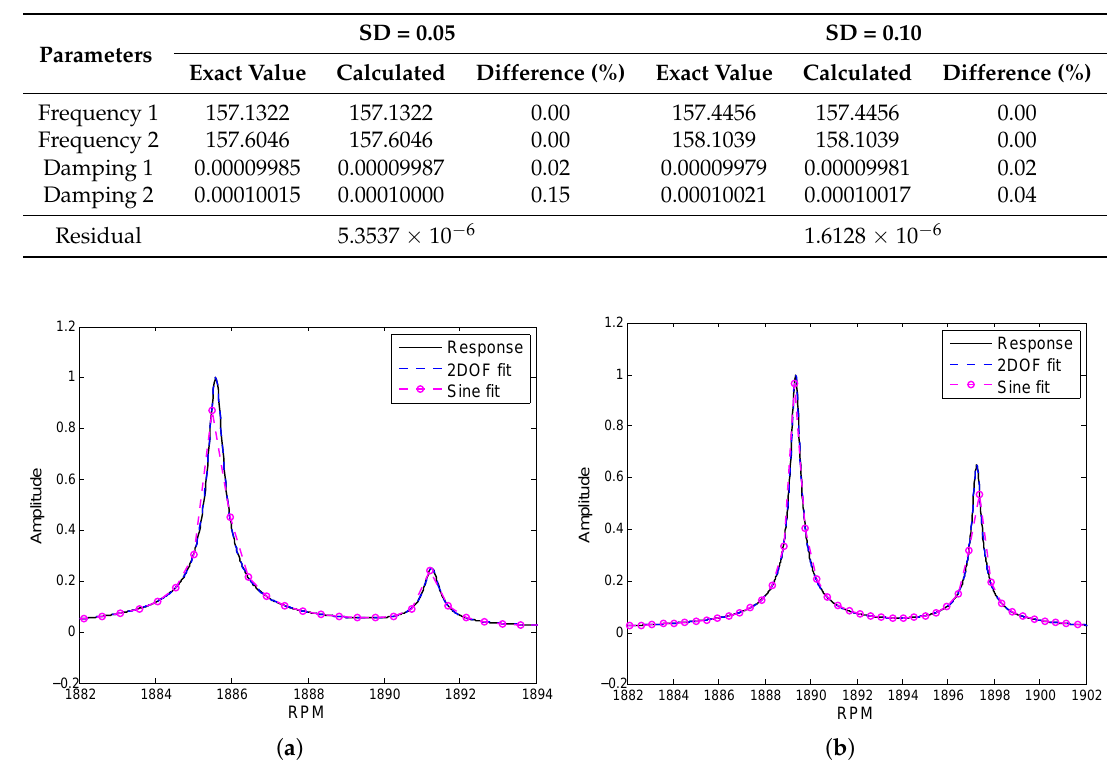
Table 2. Comparison of vibration parameters identified by the 2 degrees of freedom (2DOF) fit model with the exact values for Engine Order (EO) = 5.